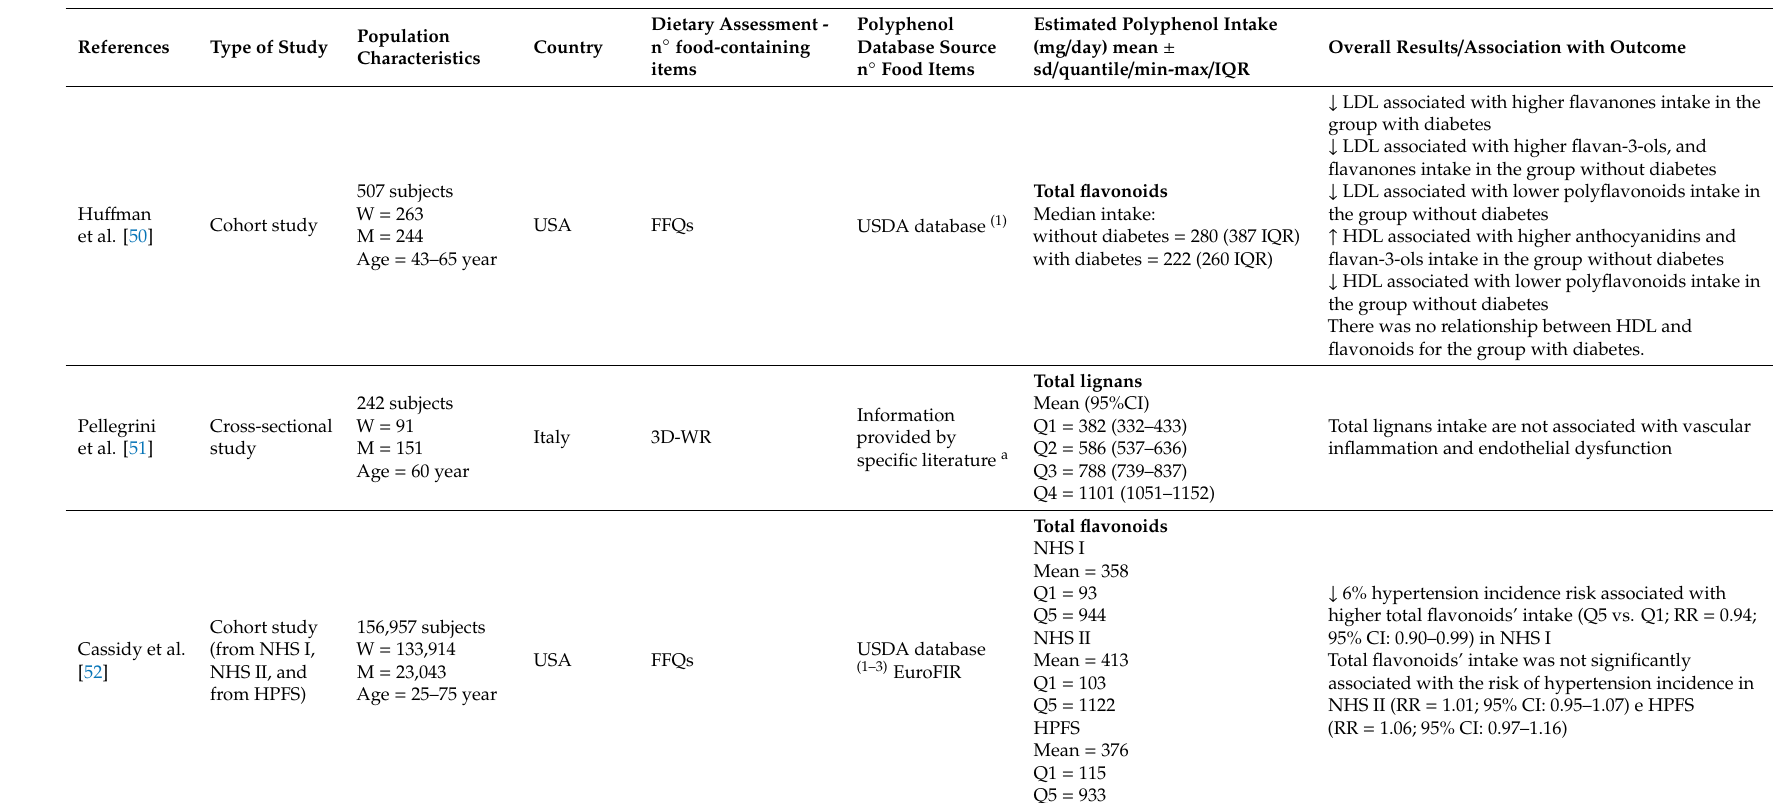
Table 2. Polyphenol intake and CVD / Diabetes